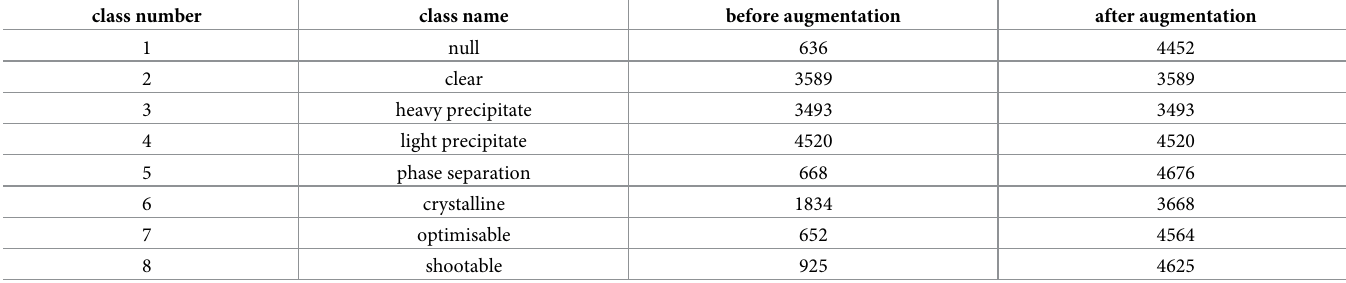
Table 1. Training data. The eight categories used to classify images in our dataset and the number of images in the training set associated with each class, before and after data augmentation. class